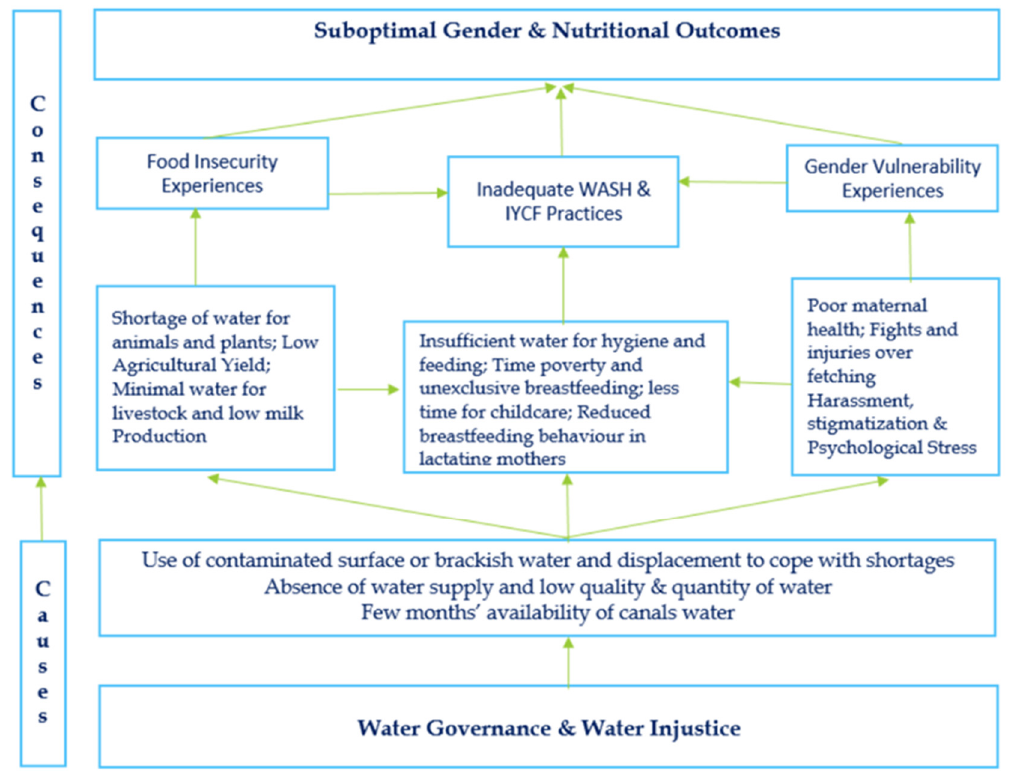
Figure 1. Locally described probable linkages and pathways showing causes of water insecurity experiences and their gender and nutritional consequences in the Rajanpur district of the South-Punjab in Pakistan.